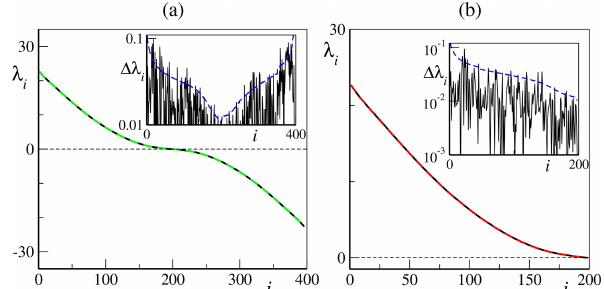
Figure 2. (a) Lyapunov spectrum for the conservative setup in Eqs. (8a) and (8b). Parameters are b = 10, K = 36 and J = 10 ( N = 396 LEs), and initial conditions are chosen such that the con- served energy is E = 36. The black solid line corresponds to h = 1, while the dashed green line corresponds to h = − 1; in the inset, the absolute difference (cid:49)λ i between the two LSs is compared with one standard error in our numerical estimate (blue dashed line). (b) The second half of the Lyapunov spectrum ( i ∈ [ 199 , 396 ] ; red dashed line) is folded under the reflection transformation λ i → − λ N − i + 1 over its first half ( i ∈ [ 1 , 198 ] ; black solid line); in the inset, the ab- solute difference (cid:49)λ i between LS and its folded transformation is compared with one standard error in our numerical estimate (dashed blue